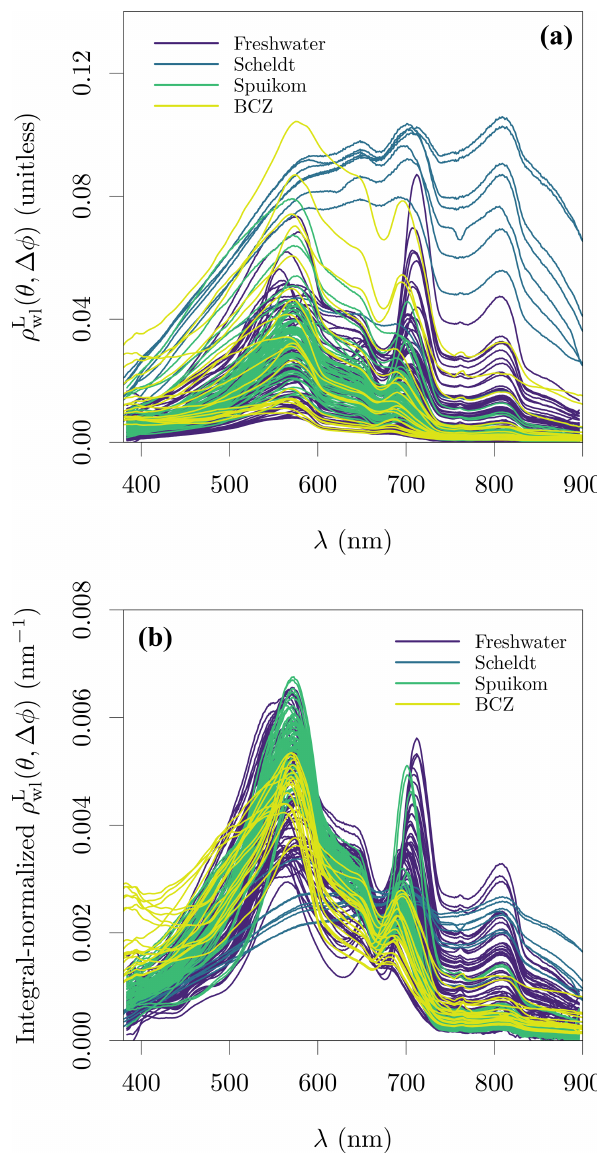
Figure 8. Lambert-equivalent water-leaving bi-hemispherical re- flectance, ρ L , estimated on Belgian water systems. The view geom- wl etry is dependent on the measurement approach, being nadir view ( θ = 0 ◦ ) for lakes and the Spuikom, and θ = 40 ◦ (cid:49)φ = 135 ◦ for the Scheldt and the BCZ. (a) Magnitude of ρ L and (b) its integral wl (0 ◦ ) values measured normalisation with respect to wavelength. ρ L wl with the on-water approach presented here were corrected for shad-